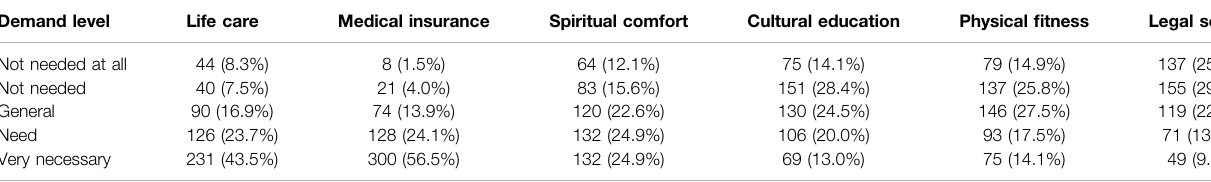
TABLE 5 | Analysis of demand preference for smart elderly care services (unit: person).